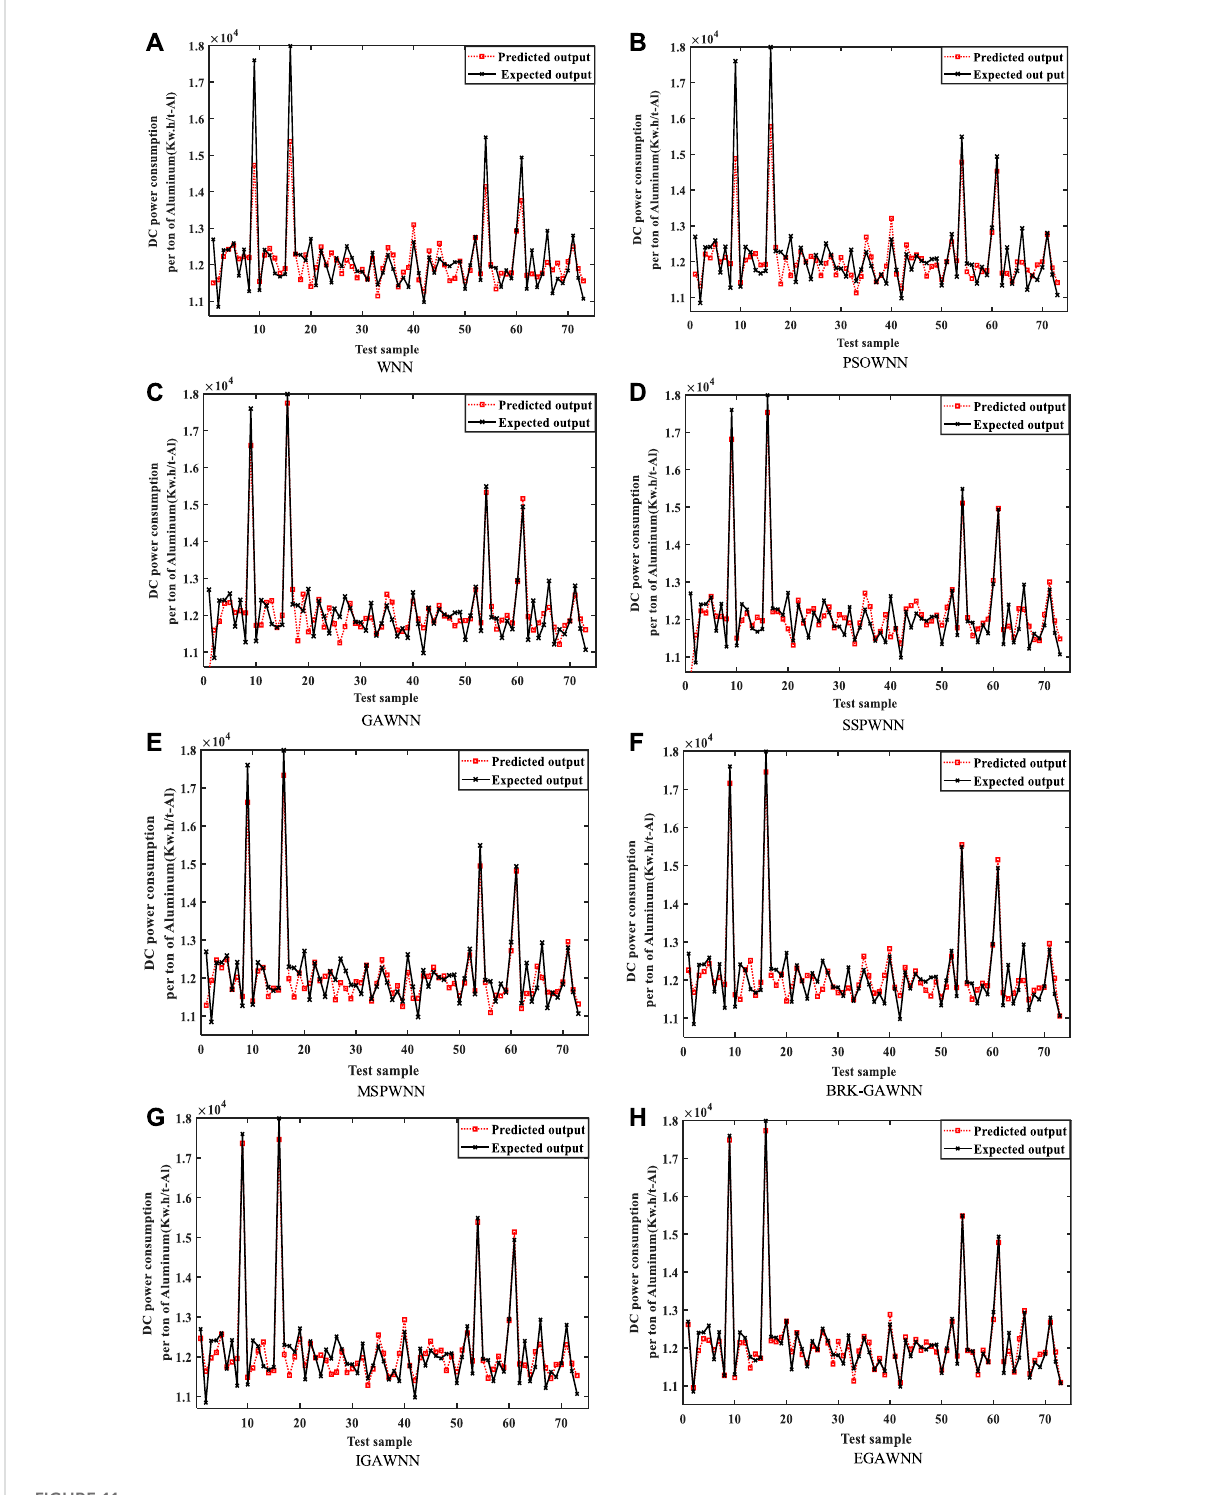
FIGURE 11 The prediction outputsintermsof DC power consumptionbased on: (A) WNN, (B) PSOWNN, (C) GAWNN, (D) SSPWNN, (E) MSPWNN, (F) BRK- GAWNN, (G) IGAWNN, and (H)